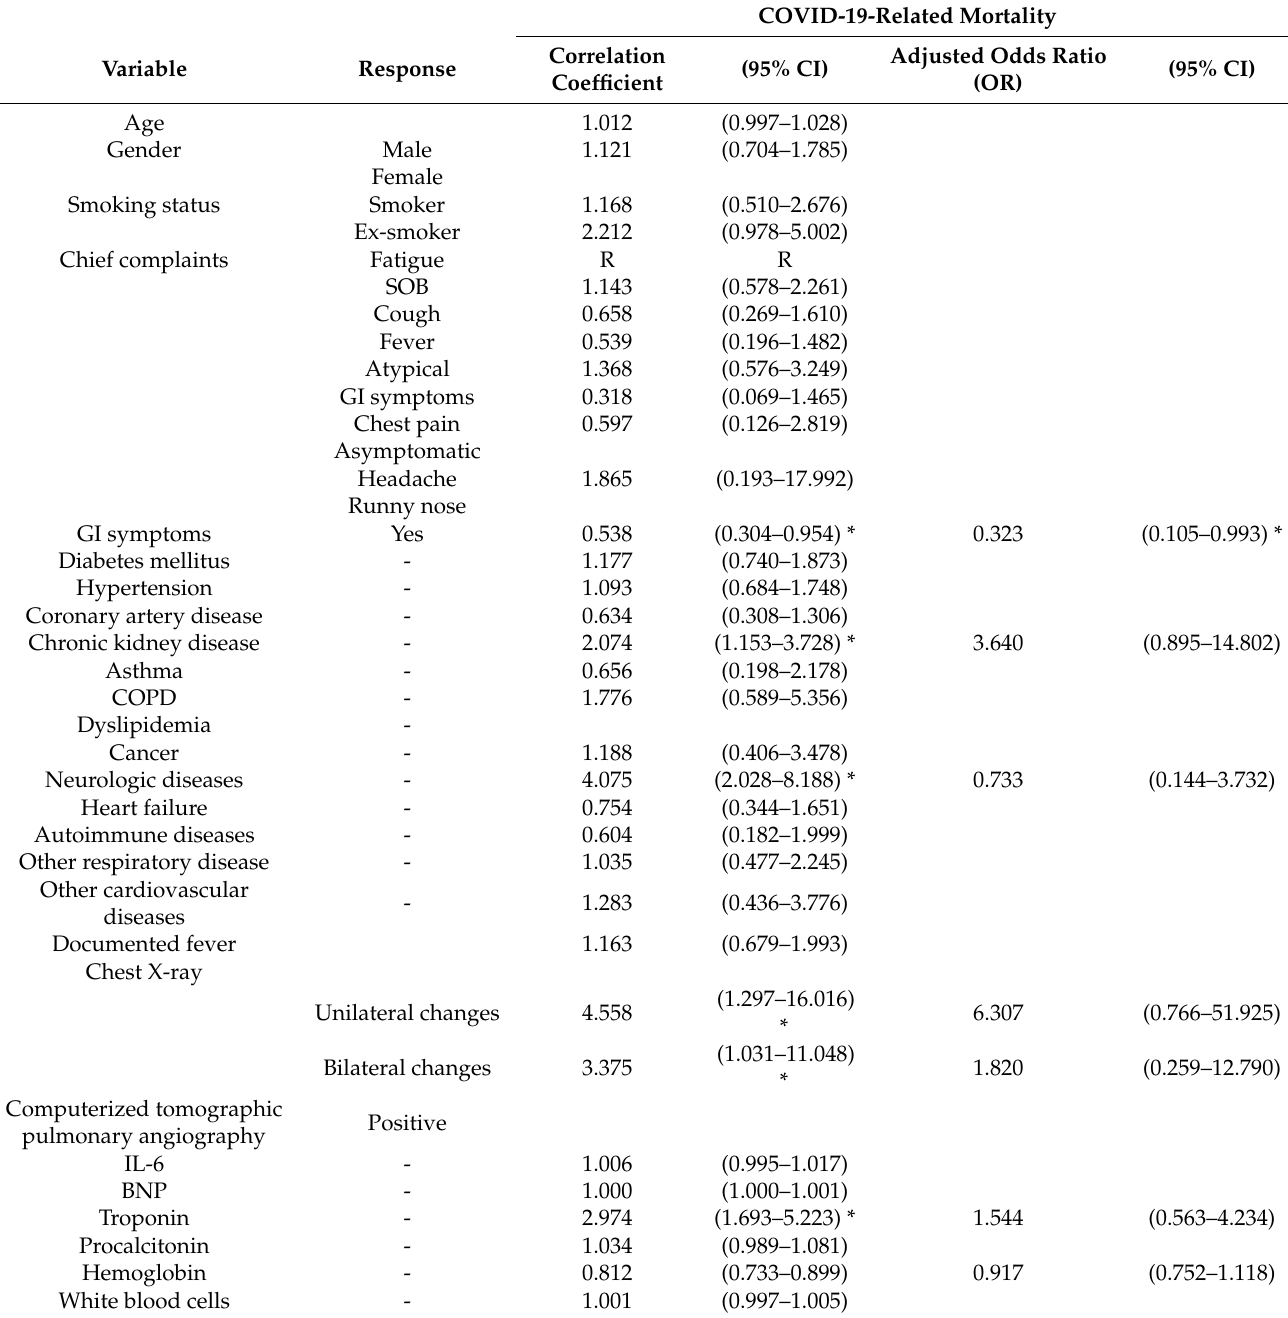
Table 6. Regression Analysis of Predictors of Intubation ( n =